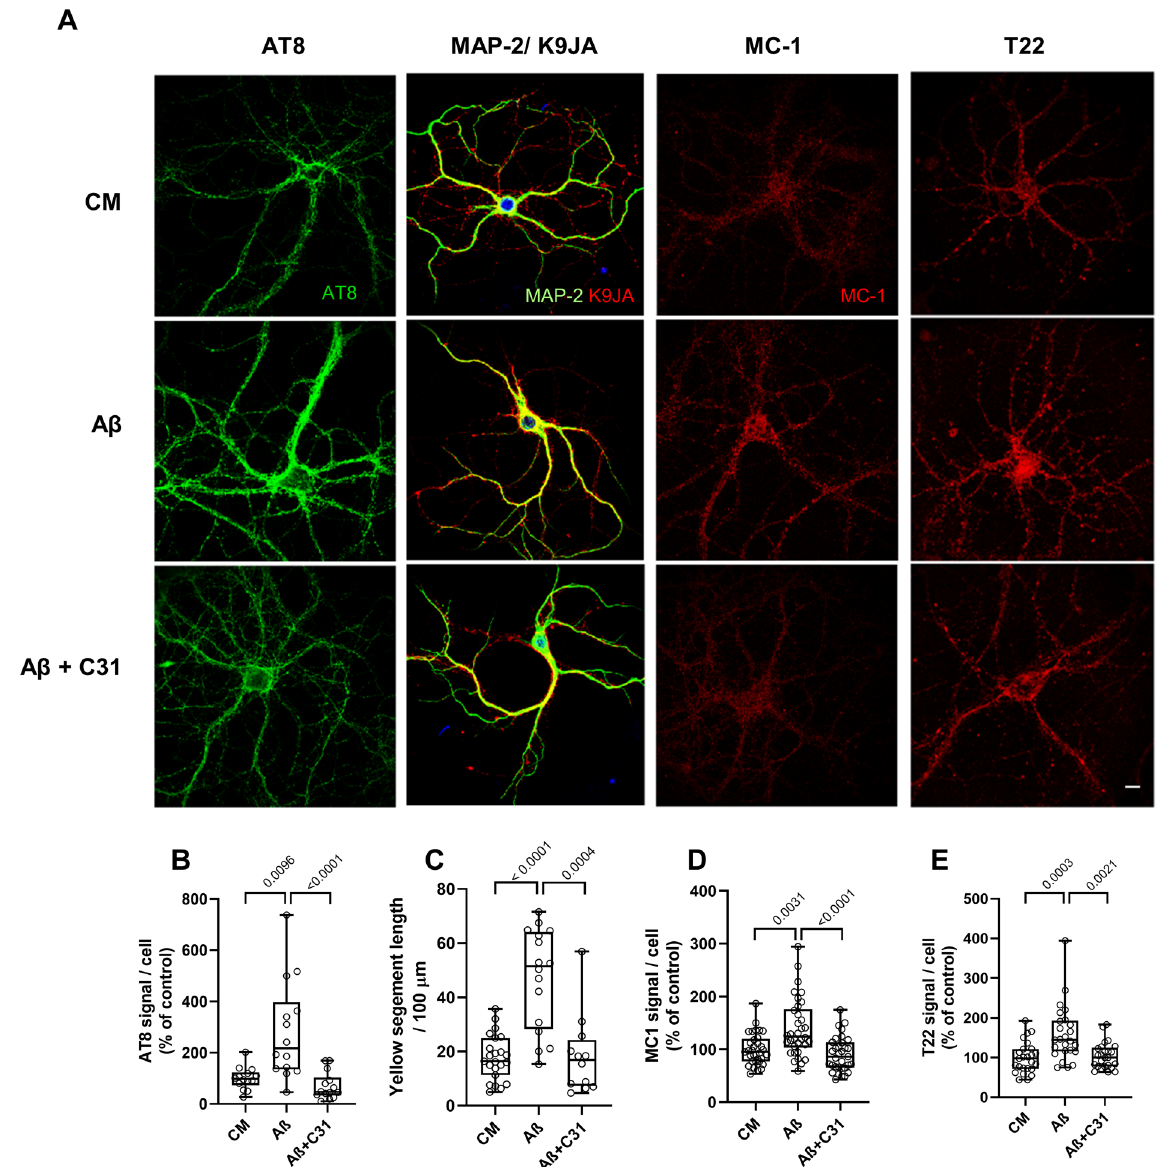
Figure 2. LM11A-31 prevents Aβ-induced tau phosphorylation, missorting, misfolding and oligomer accumulation. ( A ) Representative immunostaining for tau phosphorylation, missorting, misfolding and oligomer formation in hippocampal neurons. 21 DIV hippocampal neurons were treated with CM or Aβ ± LM11A-31 and immunostained with the indicated antibodies at 4 h for tau phosphorylation (AT8/green), 3 h for coincidence of microtubule-associated protein 2 (MAP2/green) tau and (K9JA/red) (missorting), 8 h for tau misfolding (MC-1/red) and 48 h for tau oligomerization (T22/red). Scale bar, 10 µm. ( B – E ) Total fluorescence intensity was measured and ratios of total fluorescence intensity to total cell numbers per field were calculated. ( B ) n = 14 neurons derived from 3 independent experiments. ( C ) n = 14–23 neurites derived from 3 independent experiments. ( D ) n = 30 neurons derived from 5 independent experiments. ( E ) n = 24 neurons derived from 4 independent experiments. Statistical significance of the indicated comparisons was determined in ( C – E ) using Kruskal–Wallis ANOVA with post-hoc Dunn’s multiple comparisons test and in ( B ) using Regular ANOVA with post-hoc Sidak’s multiple comparison